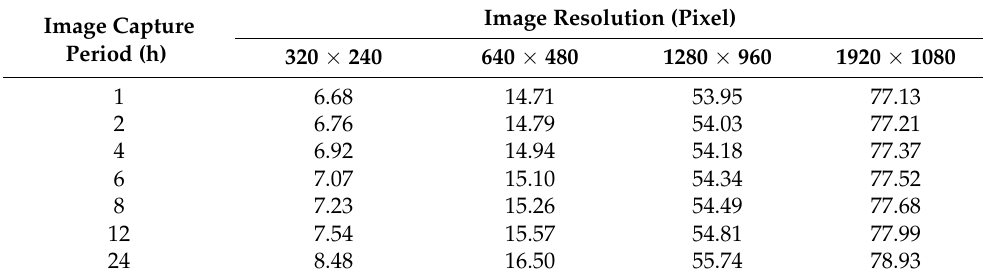
Table 2. Power consumption at different image resolutions and capture periods (Unit: mWh).